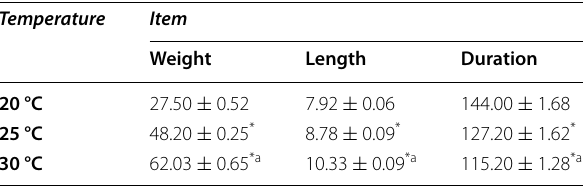
Data represented as mean SE, n 30. Significance at 0.5 level represented by ± = asterisk (*) as compared with the mean value at 20 °C. a Significance at 0.5 level as compared with the mean value at 25 °C within the same column